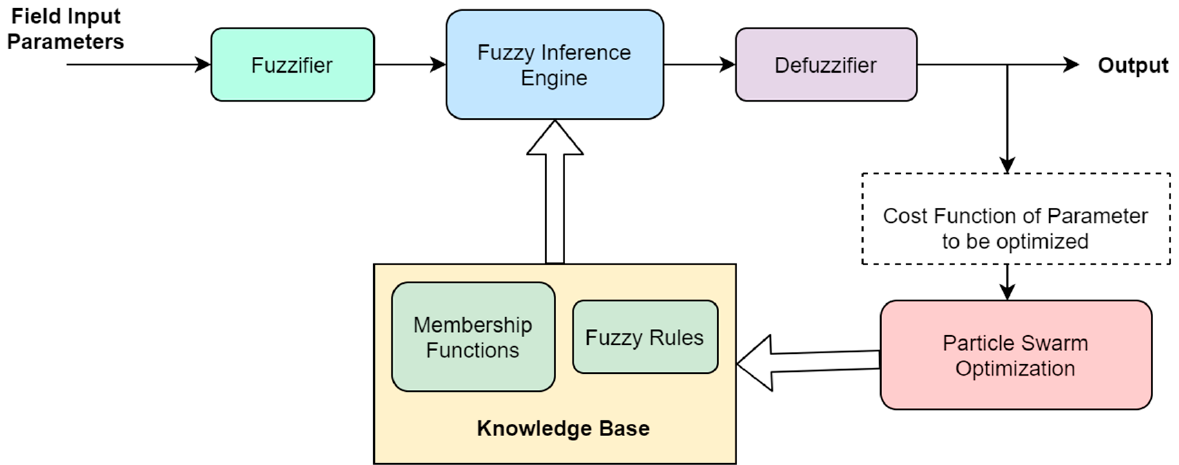
Figure 5. General flow of FIS system with PSO rule learning.